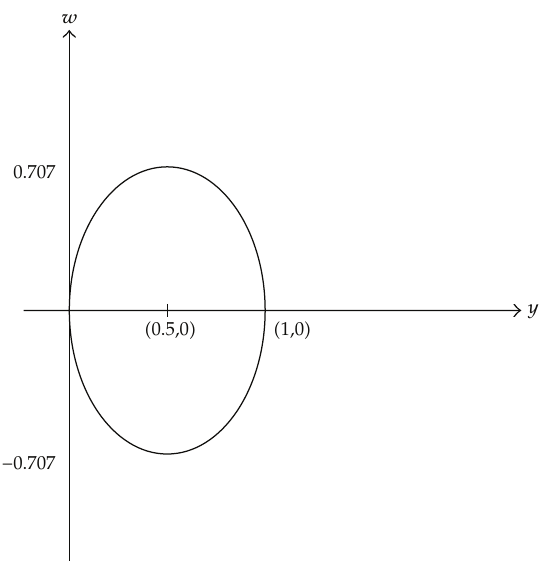
Figure 4: Spectral scale for b in Example